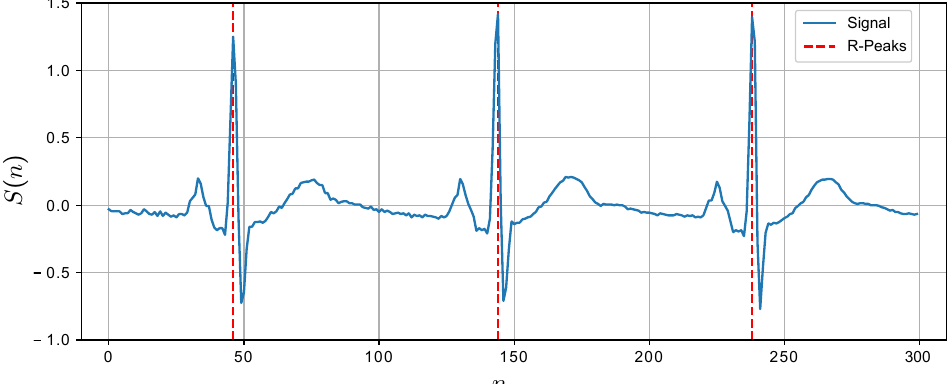
Figure 4. The output of the R-peak recognition algorithm.